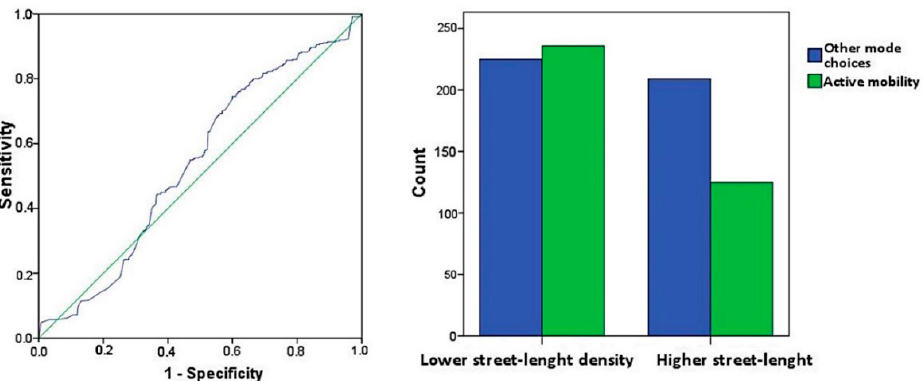
Figure 5. Curve analysis for street-length density around homes and non-commuting active mobil- ity.